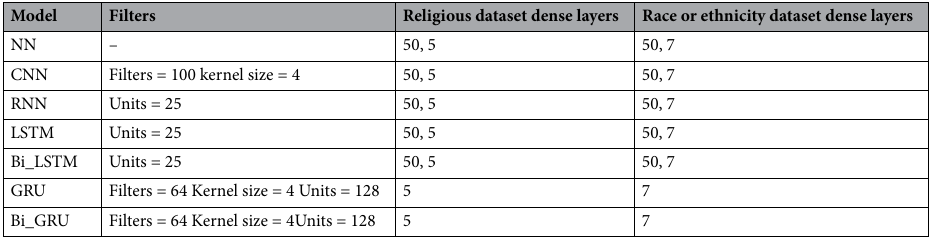
Table 2. Deep learning classifiers parameter